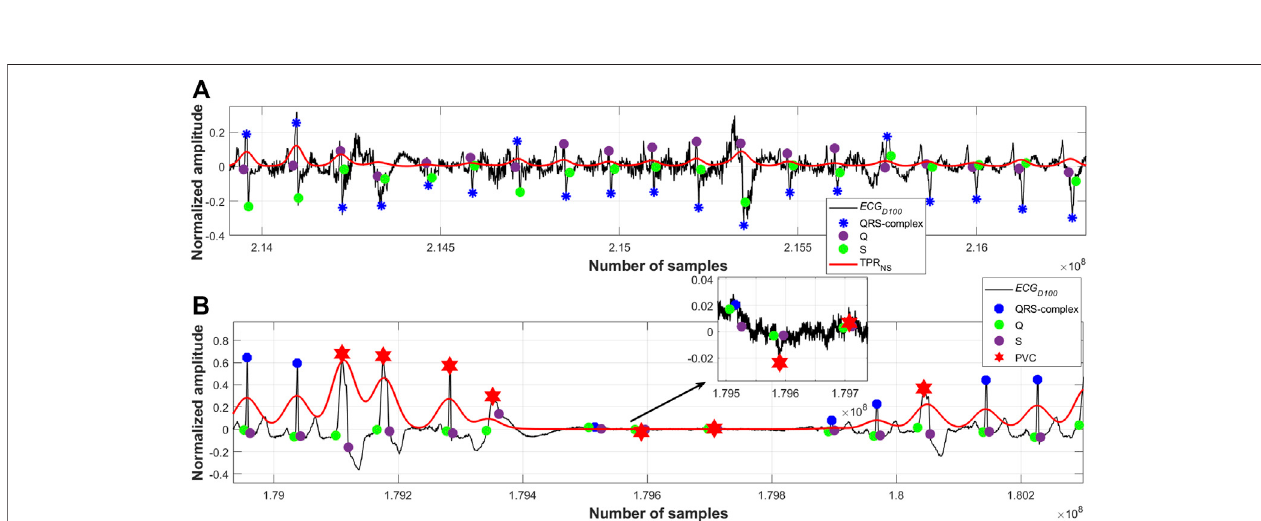
Frontiers in Signal Processing |